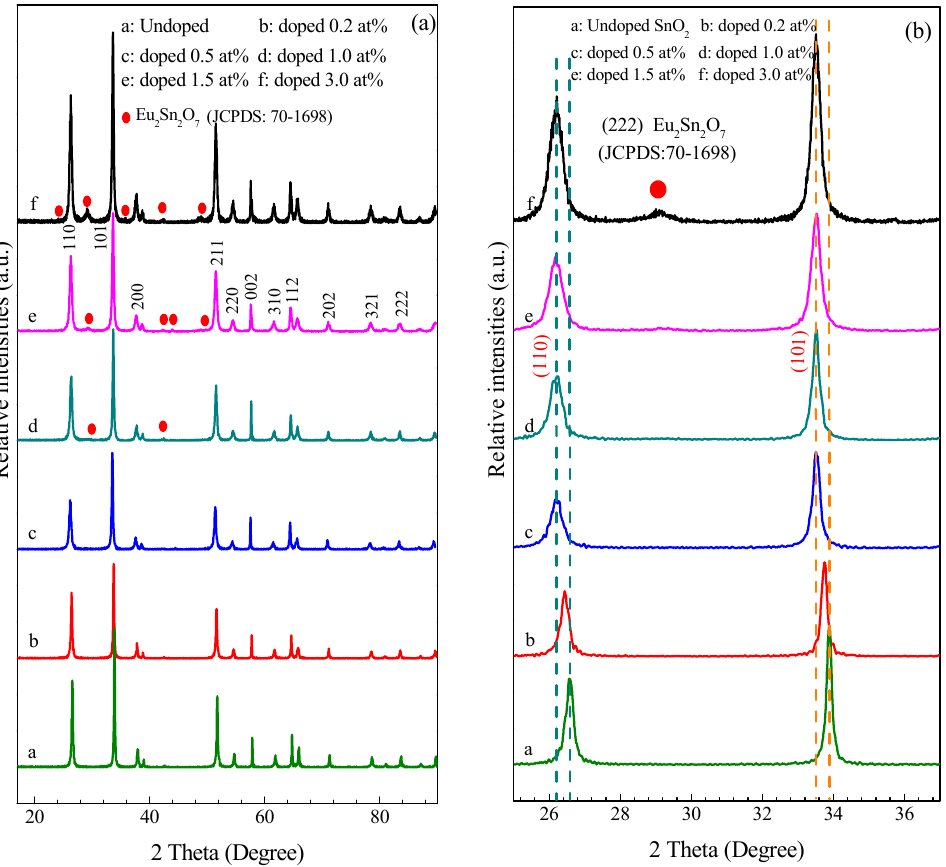
Figure 3. ( a ) X-ray diffraction (XRD) patterns of Eu-doped SnO 2 nanorods arrays; ( b ) Enlarge XRD patterns showing the shift of (110) and (101) peaks.